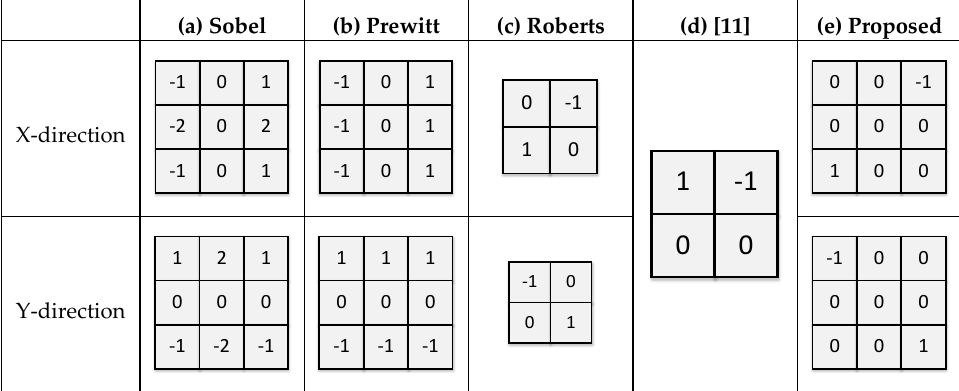
Figure 4. ( a ) The Sobel mask, ( b ) the Prewitt mask, ( c ) the Roberts mask, ( d ) the column-comparing mask [11], and ( e ) the mask built into column circuits.